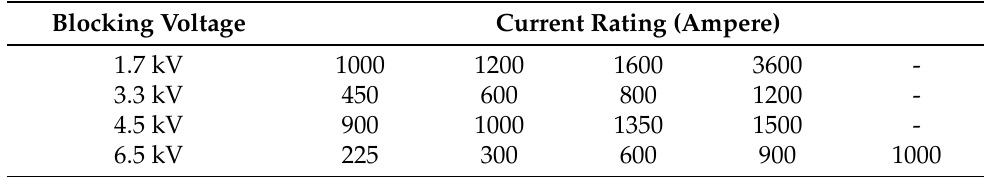
Table 3. Market availability of high-voltage IGBT